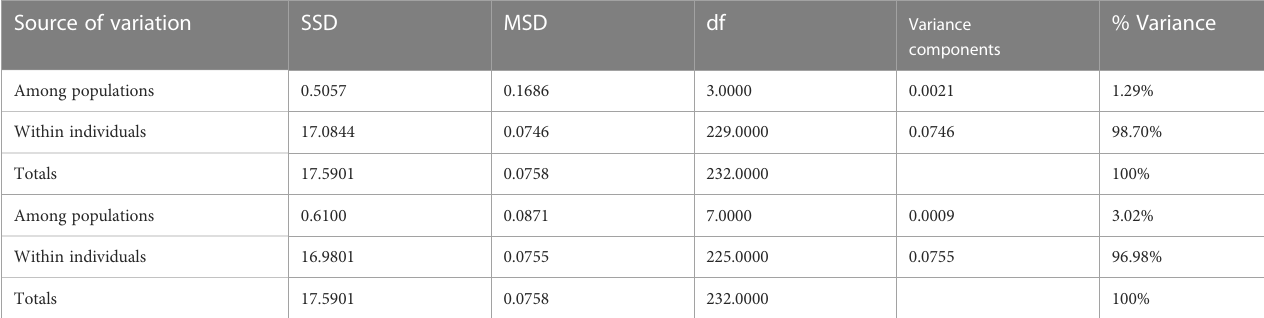
TABLE 4 Molecular analysis of variance for the Chinese fi r different breeding population generations and different germplasm source locations. Source of variation % Variance Among populations Within individuals